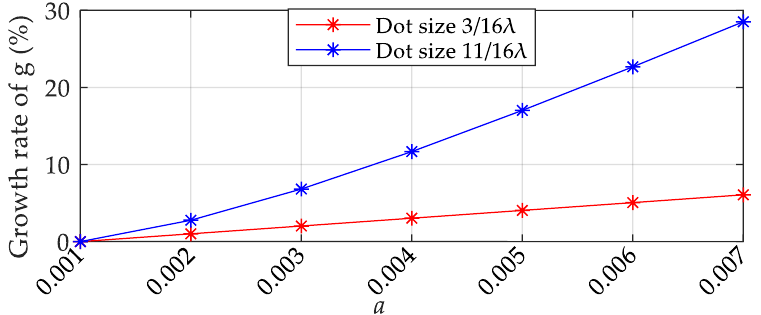
Figure 8. Growth rate of the SAW gyroscopic effect at points 3 / 16 λ and 11 / 16 λ .